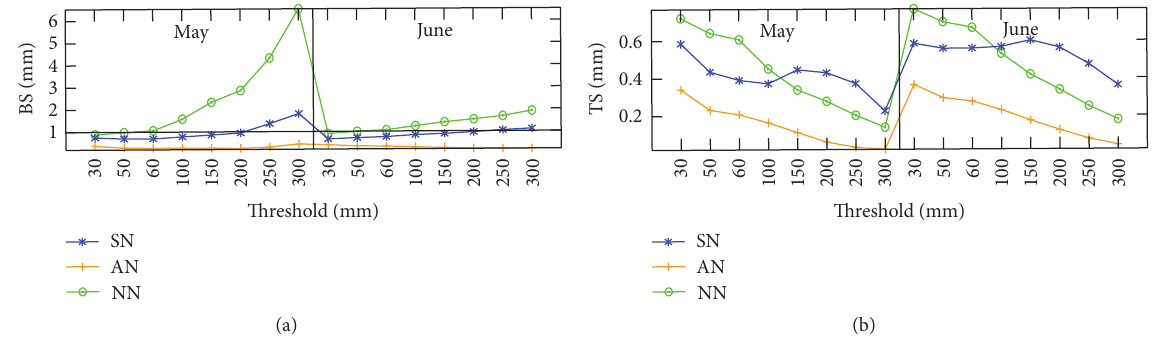
Figure 3: The BS and TS at different threshold for monthly accumulated precipitation in May and June, 2011.